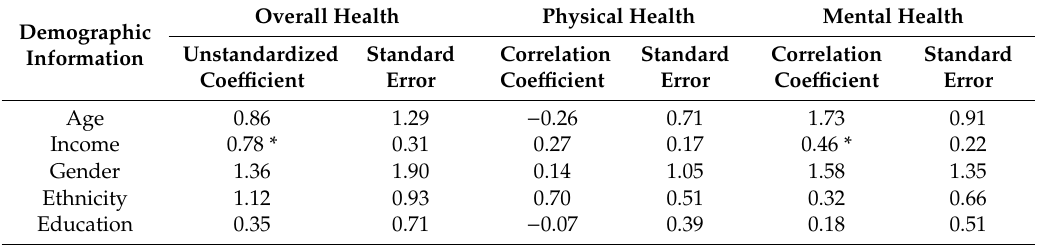
Table 2. Multiple Regressions between Five Demographic Variables and Health Outcomes of